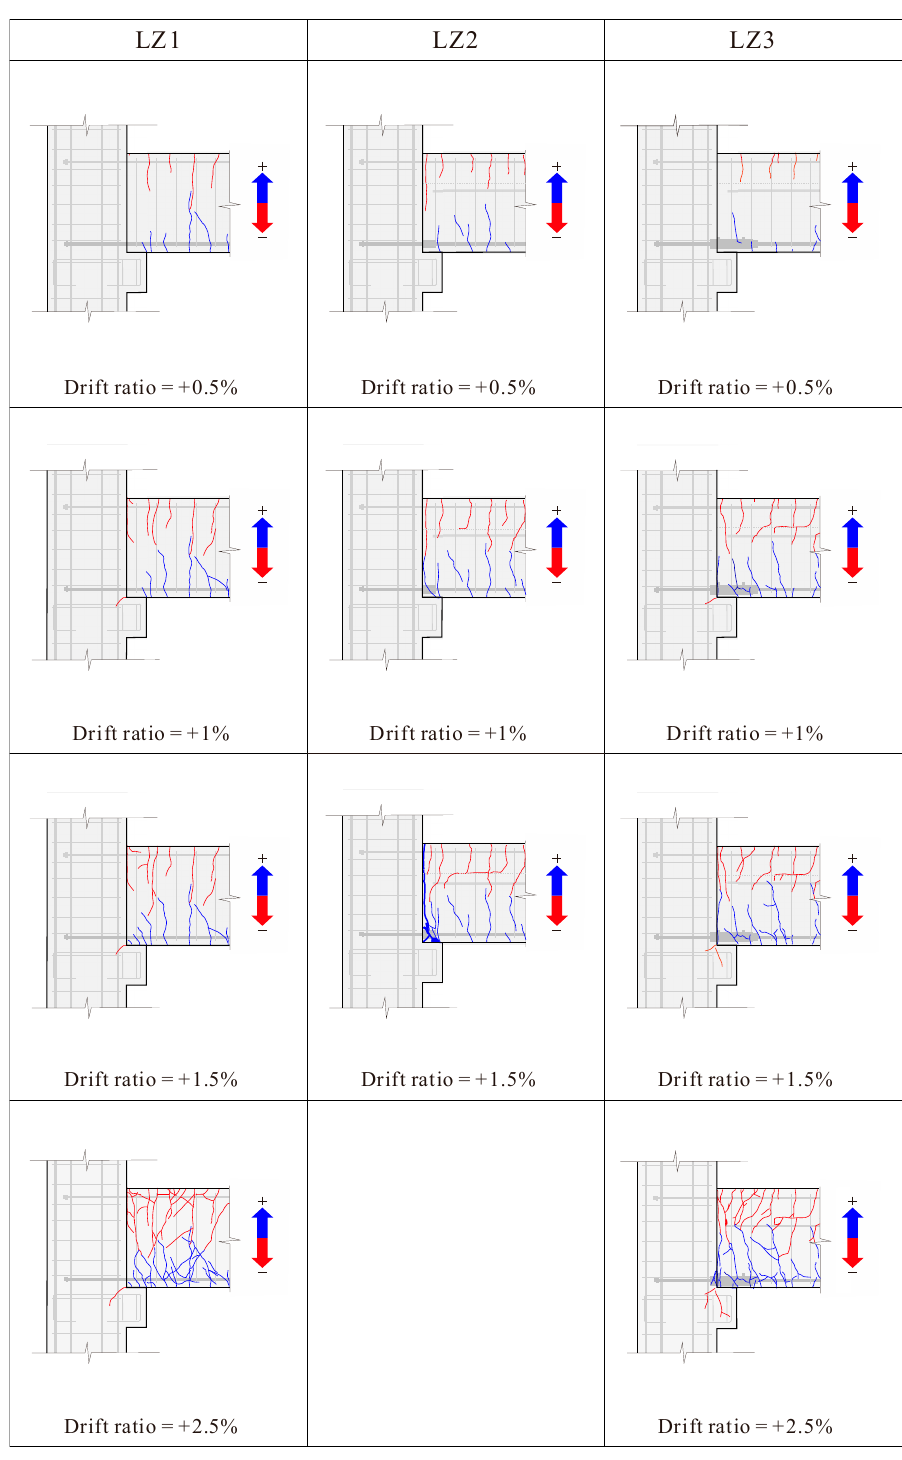
Figure 5. Comparison of cracking patterns before significant concrete crushing.